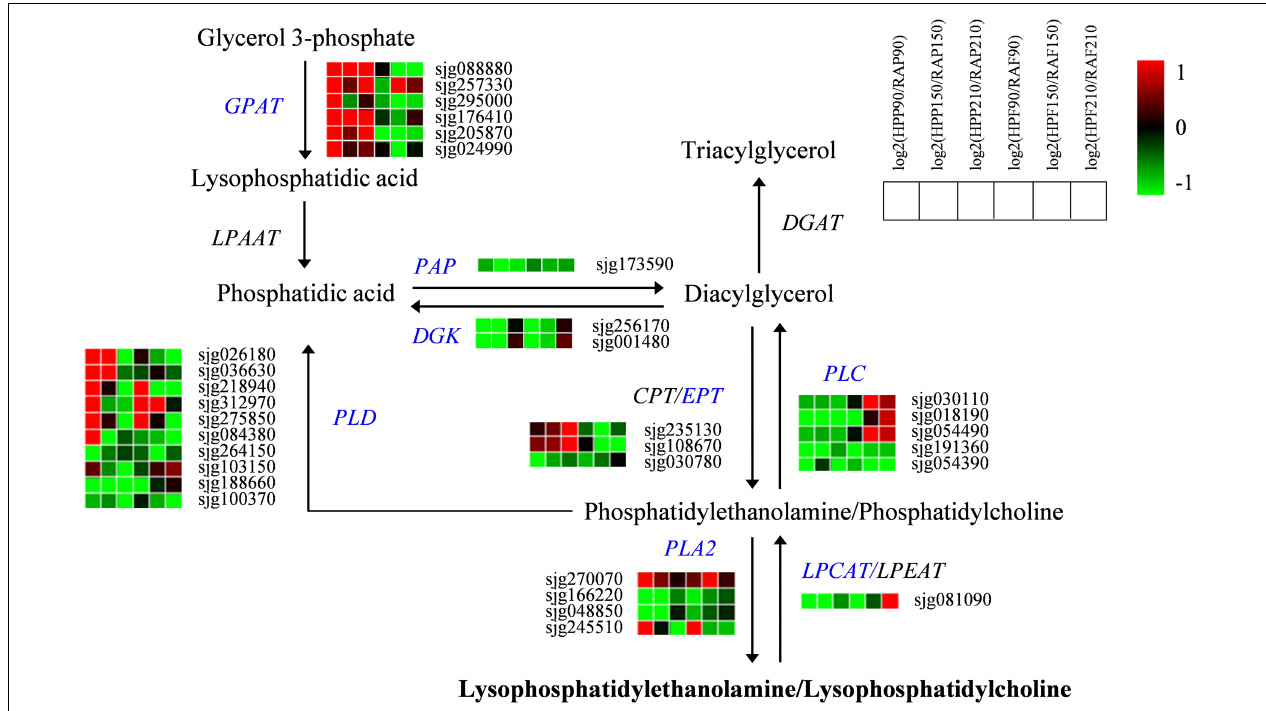
FIGURE 6 | Expression profiles of genes from the glycerophospholipid pathway in the peel and flesh of kumquat fruits. The color scale from green (low) to red (high) represents the values of the log2 ratio (HP/RA) at 90, 150, and 210 DAF. The differentially expressed genes are highlighted in blue. GPAT, glycerol-3-phosphate acyltransferase; LPAAT, Lysophosphatidic acid acyltransferase; PAP, phosphatidate phosphatase; DGK, diacylglycerol kinase; EPT, ethanolaminephosphotransferase; CPT, cholinephosphotransferase; PLA, phospholipase A; PLC, phospholipase C; PLD, phospholipase D; LPCAT, lysophosphatidylcholine acyltransferase; LPEAT, lysophosphatidylethanolamine acyltransferase; DGAT, diacylglycerol O-acyltransferase.